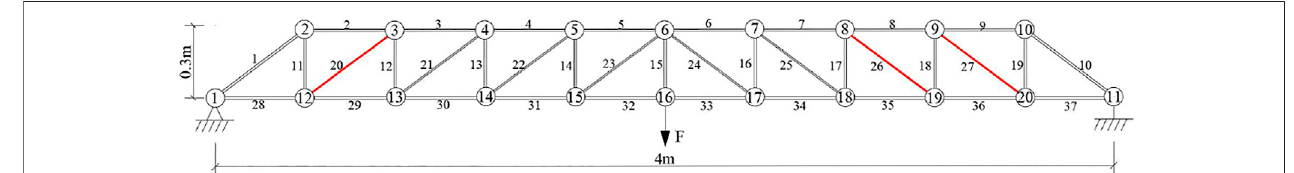
FIGURE 9 | Sketch of truss